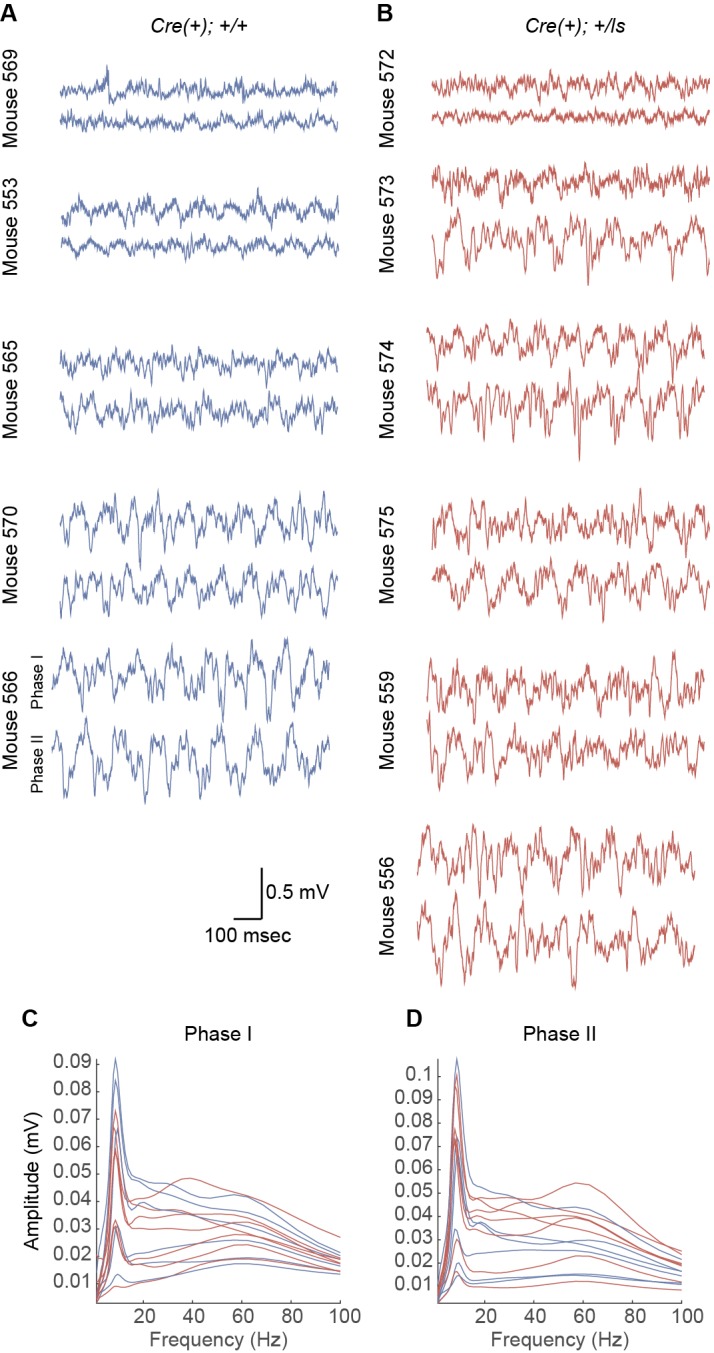
Amplitude of theta oscillations in each mouse during Phase I and Phase II recording sessions.(A–B) CA1 LFP recordings from WT (A) and Syngap1 mutant (B) mice during Phase I and Phase II sessions. (C–D) Average amplitude spectra for each mouse during Phase I (C) and Phase II (D) sessions. Individual mice are indicated with individual lines, and WT and Syngap1 mutant spectra are depicted in blue and red, respectively.